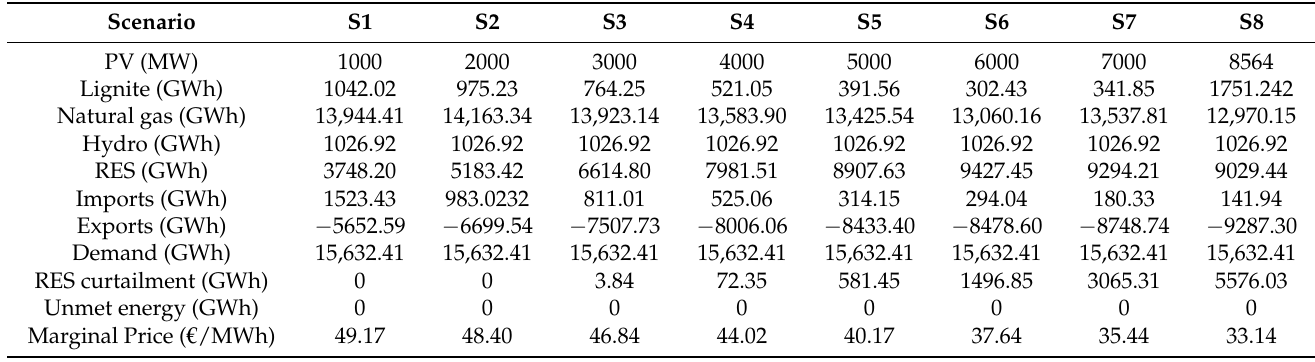
Table 3. Solutions of the market-clearing problem.